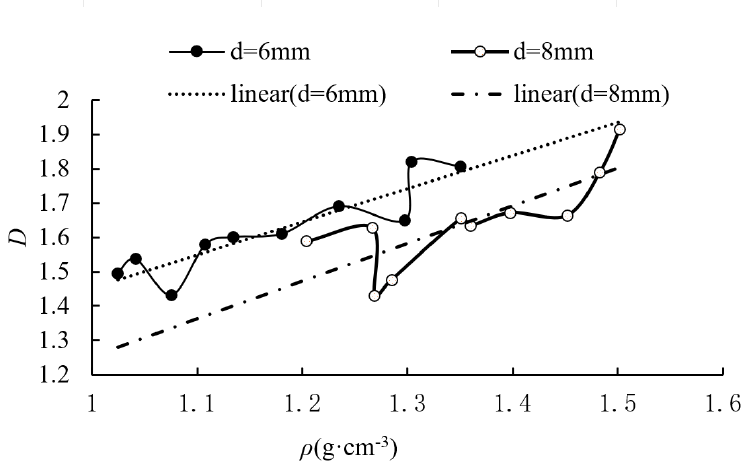
Figure 7. Relationship between ρ and D